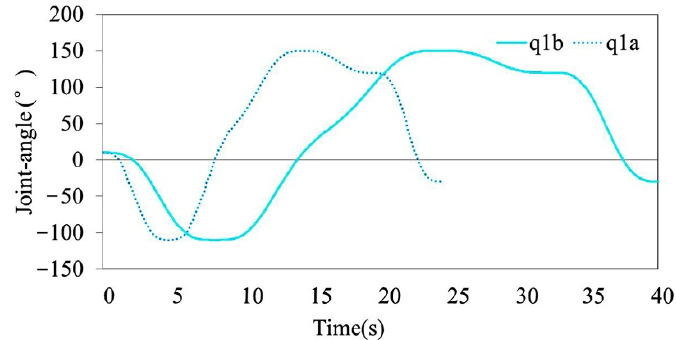
Figure 3. Comparison before and after optimization.